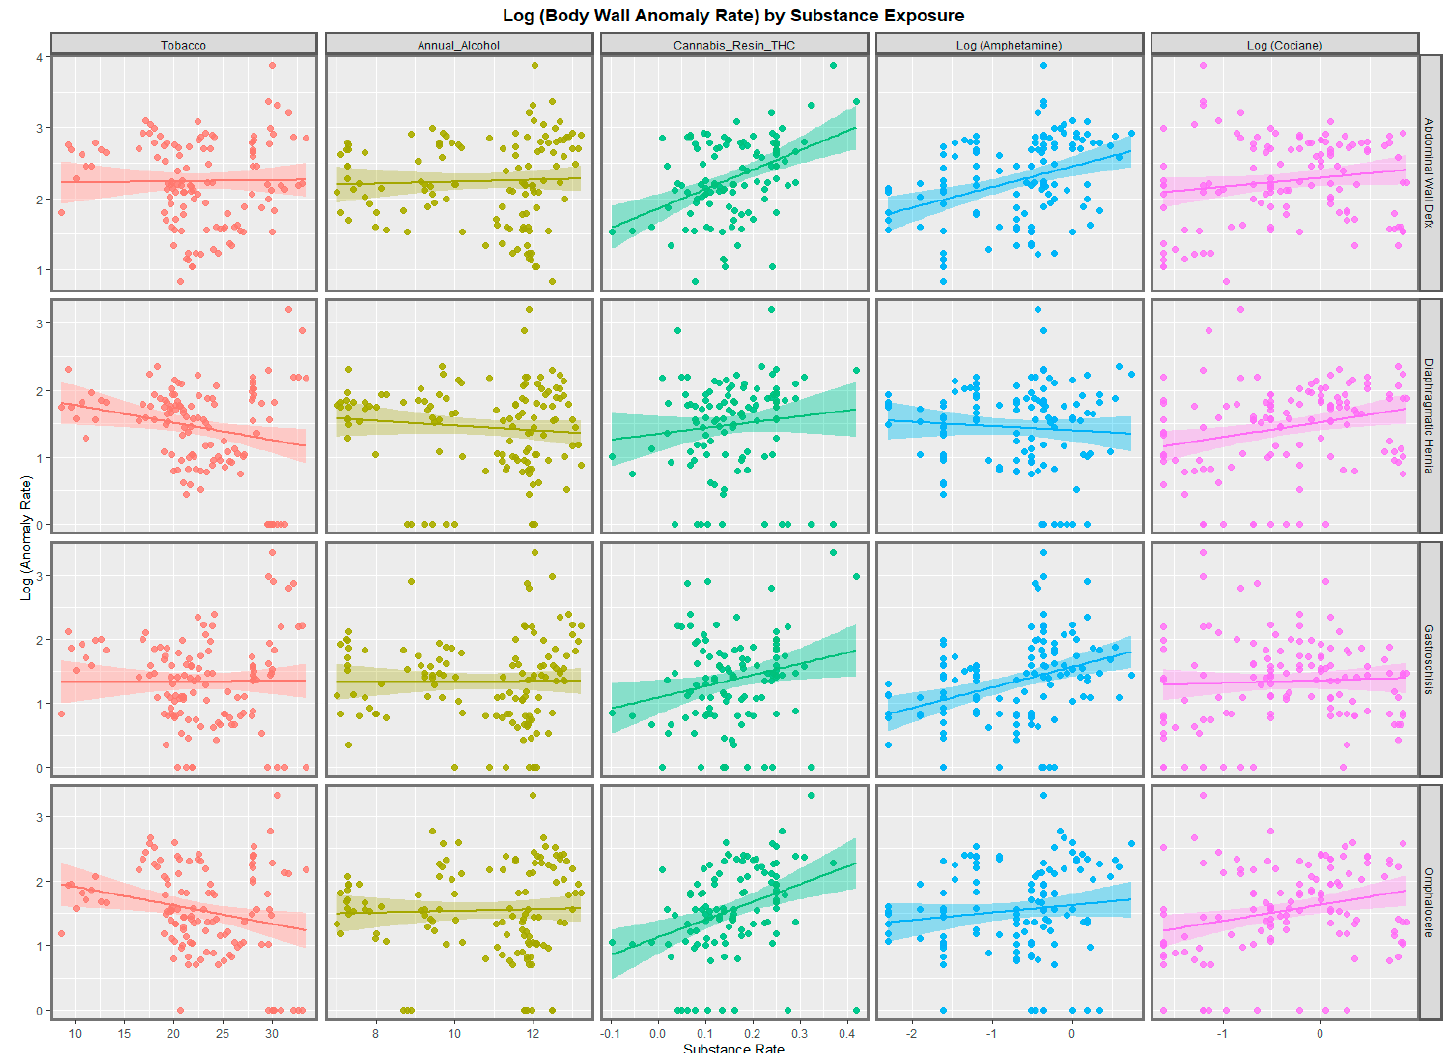
Figure 1. Paneled scatterplots of body wall anomalies by anomaly and by substance.